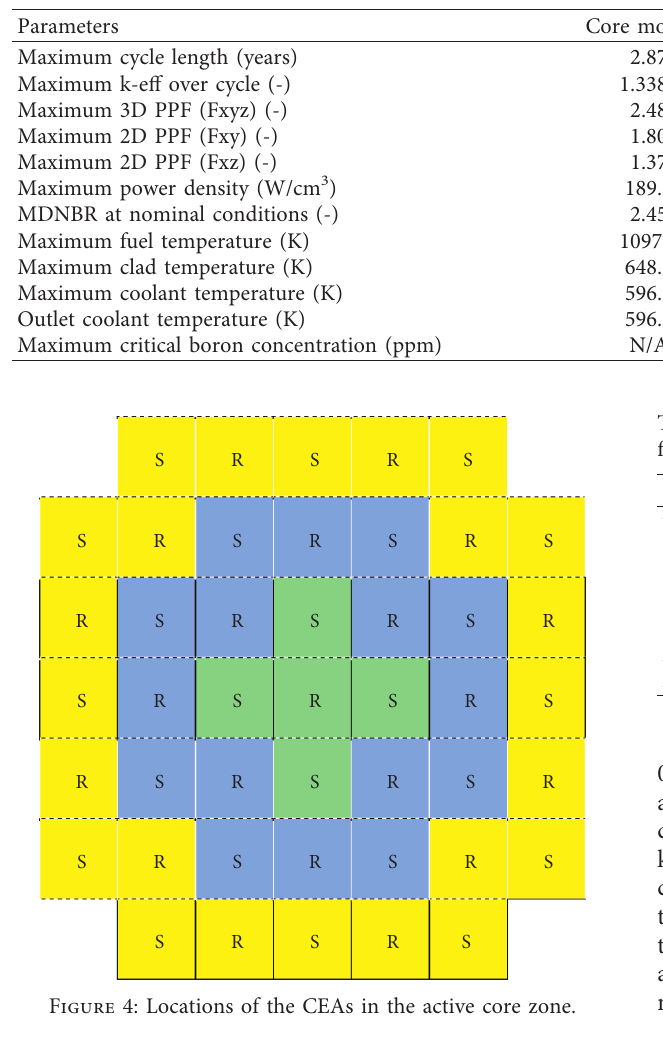
Figure 3: Core configurations of the SMR (yellow, blue, and green blocks represent fuel assembly assemblies with 4.45, 3.40, and 2.35 wt.% U-235 enrichment, respectively. White block represents the water-filled position). (a) Core model 1. (b) Core model 2. (c) Core model 3. Table 3: Summary of analysis results of the different core configurations.